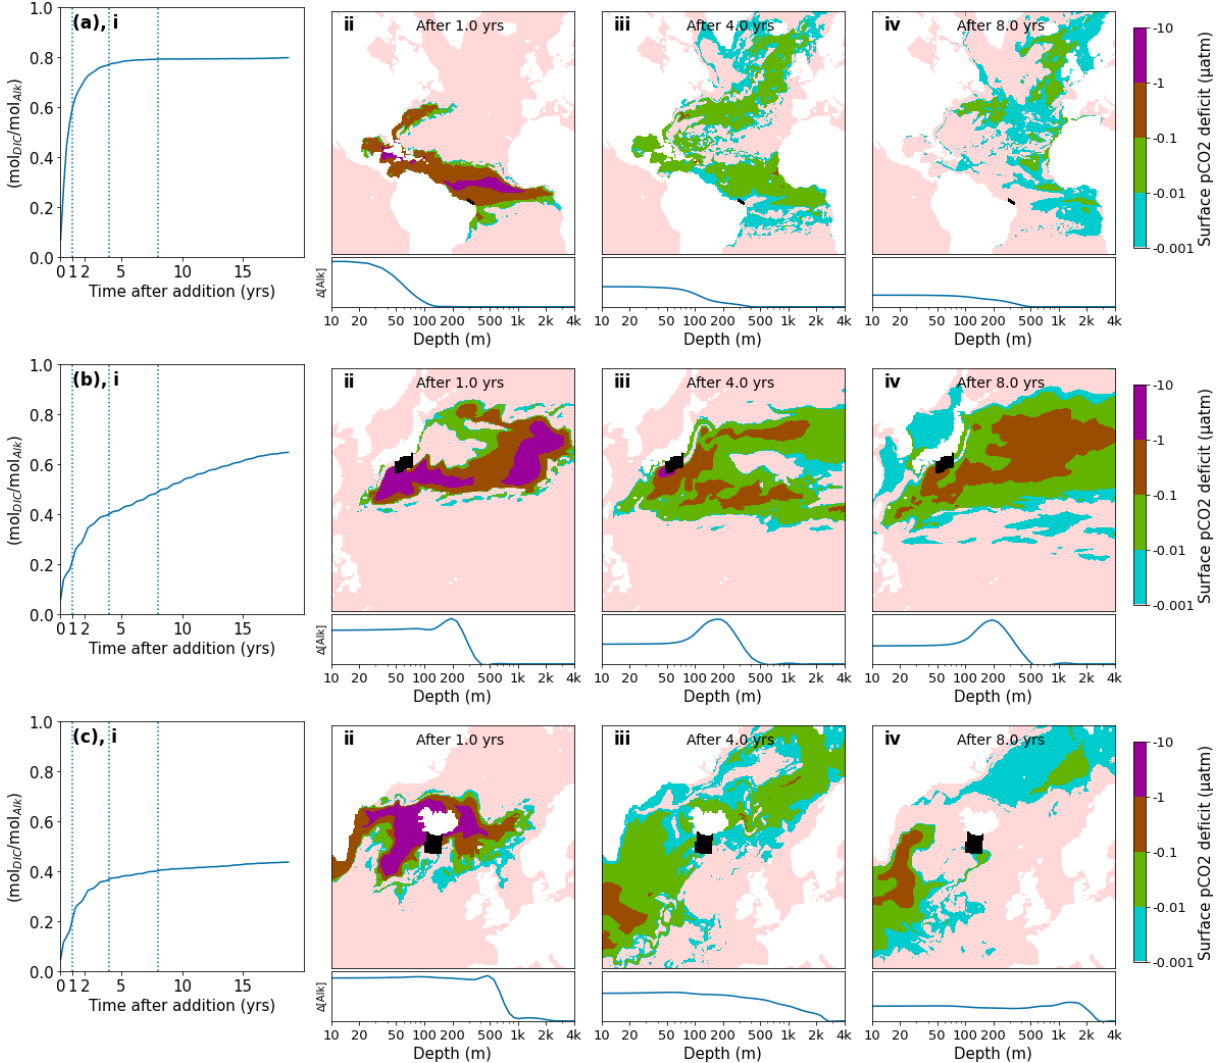
Figure 6. Pulse additions of alkalinity in 3 representative locations: (a) Brazil, (b) Japan, (c) Iceland. (i) Excess quantity of CO 2 absorbed (relative to the reference simulation) over time following a 1 month pulse injection at various near coast locations, expressed as a molar fraction of the amount of alkalinity added ( η CO ). A significant variation of uptake time scales is observed, depending on the speed at 2 which excess alkalinity is removed from surface layers, both in the short term and in the long term. (ii–iv) Spatial detail of surface p CO 2 deficit and depth residence of excess alkalinity for the same 3 locations shown in (i) . The initial injection location is indicated by a black area. The surface p CO 2 deficit is plotted over time (note the log scale of the color map), indicating areas which are absorbing extra CO 2 (or emitting less CO 2 ) compared to the reference simulation. Below, the relative excess alkalinity is plotted against the depth of the water column (averaged over all lat/long grid points for each depth). Further locations are shown in detail in Fig.